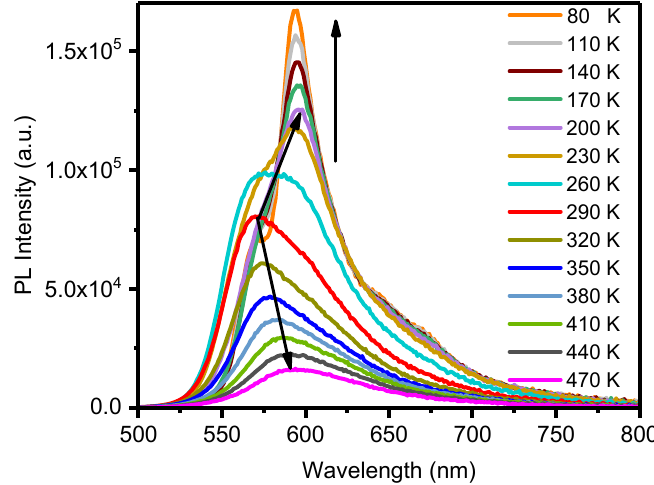
Figure 6. Temperature-dependent photoluminescent spectra of an Au 4 Cu 2 cluster in solid state at 80–470 K upon excitation at 397 nm.